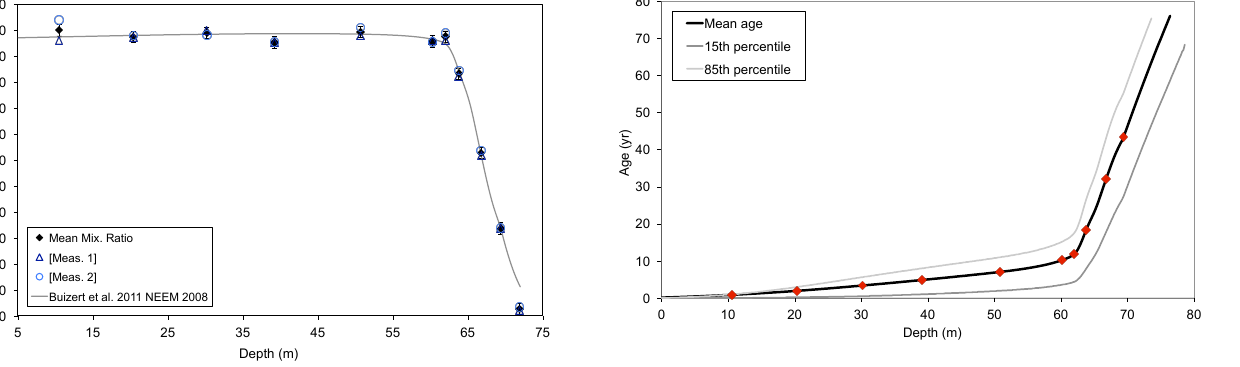
Fig. 3. Vertical profiles of CFC-12 mixing ratios (ppt) from firn air extracted from the S2 hole, NEEM, Greenland, for independent measurements ([Meas.] in legend) 1 and 2, and mean values. Error bars represent 98% confidence intervals with respect to the mean. For reference the model results from Buizert et al. (2012) (NEEM 2008, grey trace) are also included.